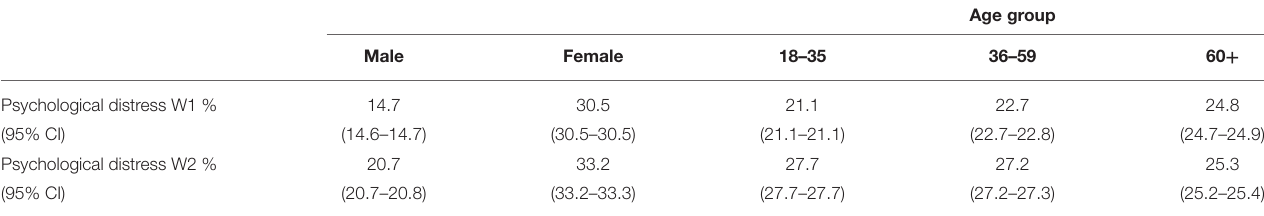
TABLE 3 | Psychological distress by sex, age and